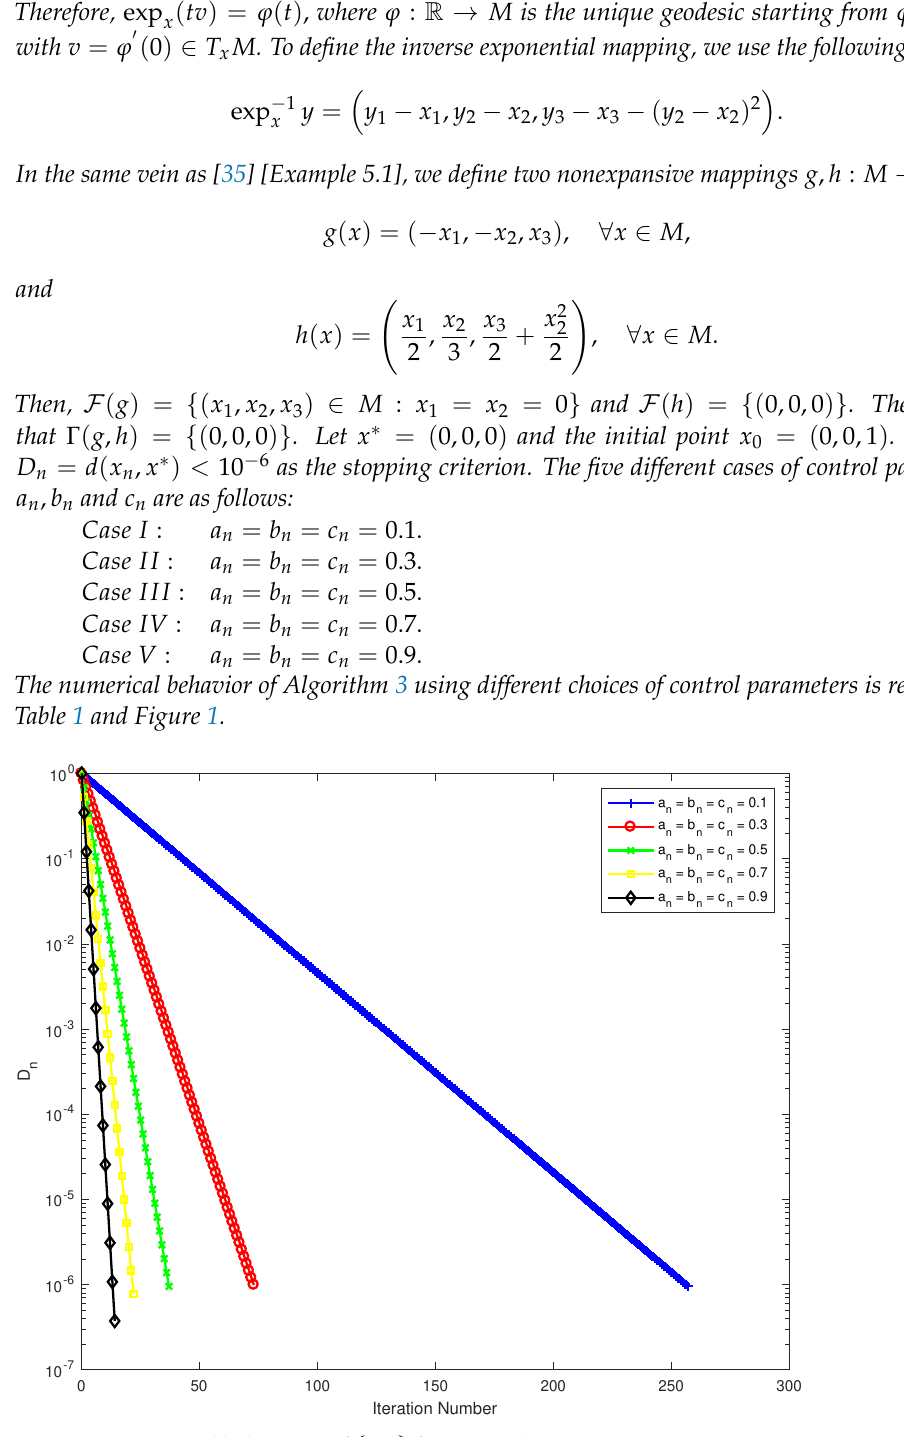
Figure 1. Numerical behaviour of { D n } for Example